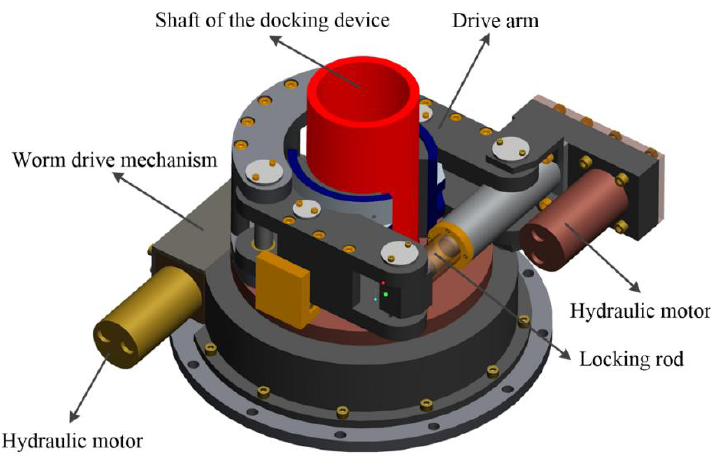
Figure 2. Adjustment module of the heading angle.